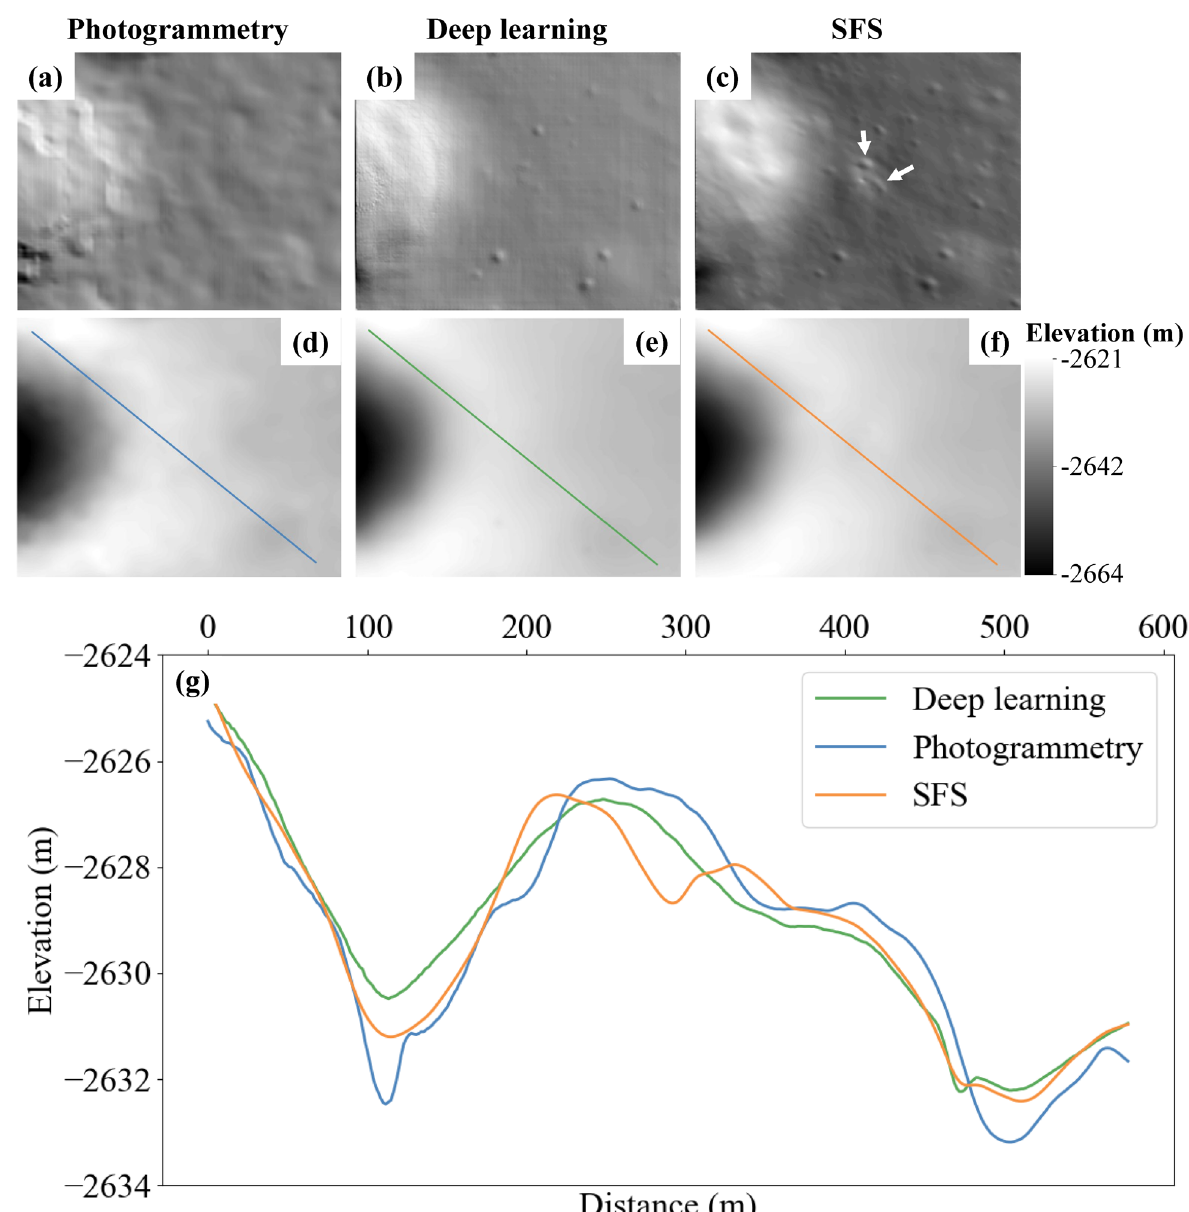
Figure 4. DTM generation results and comparison. The three top panels (a,b,c) show the hill shaded maps with the same illumination azimuth and elevation angles of the original LROC NAC images. The center panels (d,e,f) are the generated DTMs by stereo-photogrammetry, deep learning, and SFS, respectively. The bottom panel (g) shows the profile comparison between the three DTMs in middle panel. The location of the profile is shown on the DTMs. (For interpretation of the references in the legend, the reader is referred to the web (colour) version of this